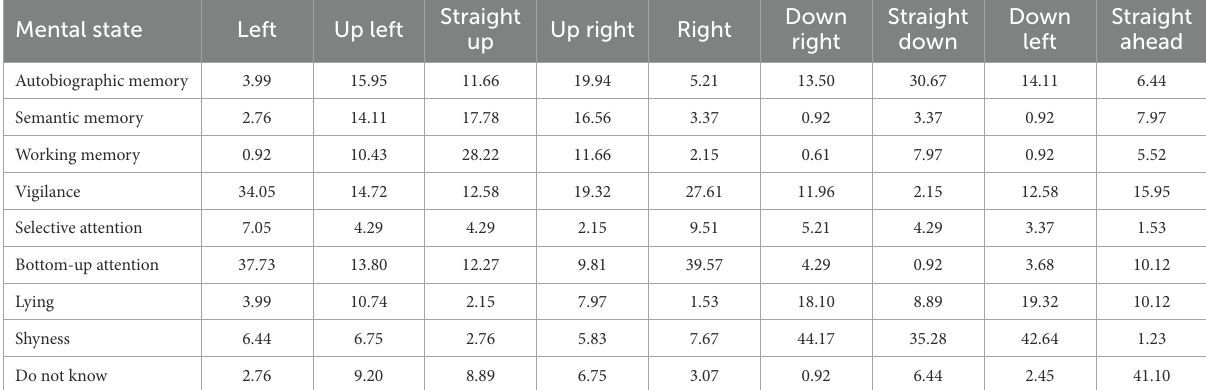
TABLE 5 Frequencies of responses (in %) during Experiment 2 for the condition with gaze at high eccentricity. Mental state Left Up left